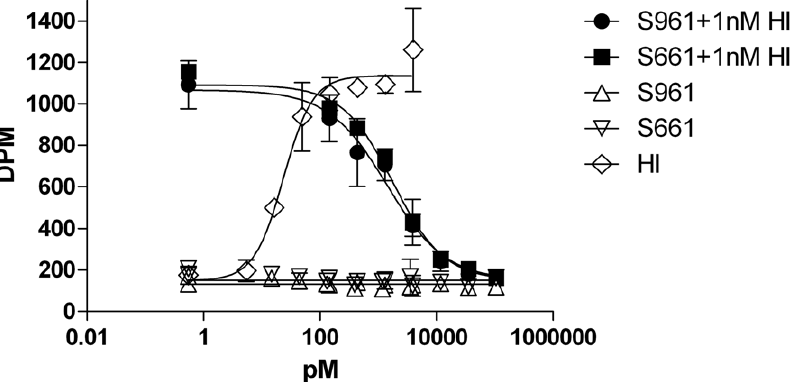
Figure 5. S961 did not stimulate lipogenesis in rat adiopocytes. Primary rat adipocytes were stimulated with increasing concentrations of S961or S661 alone or in combination with 1 nM insulin. Insulin alone was included as a reference. The graph is representative of two independent experiments each comprising duplicate determinations. Error bars show one standard deviation.